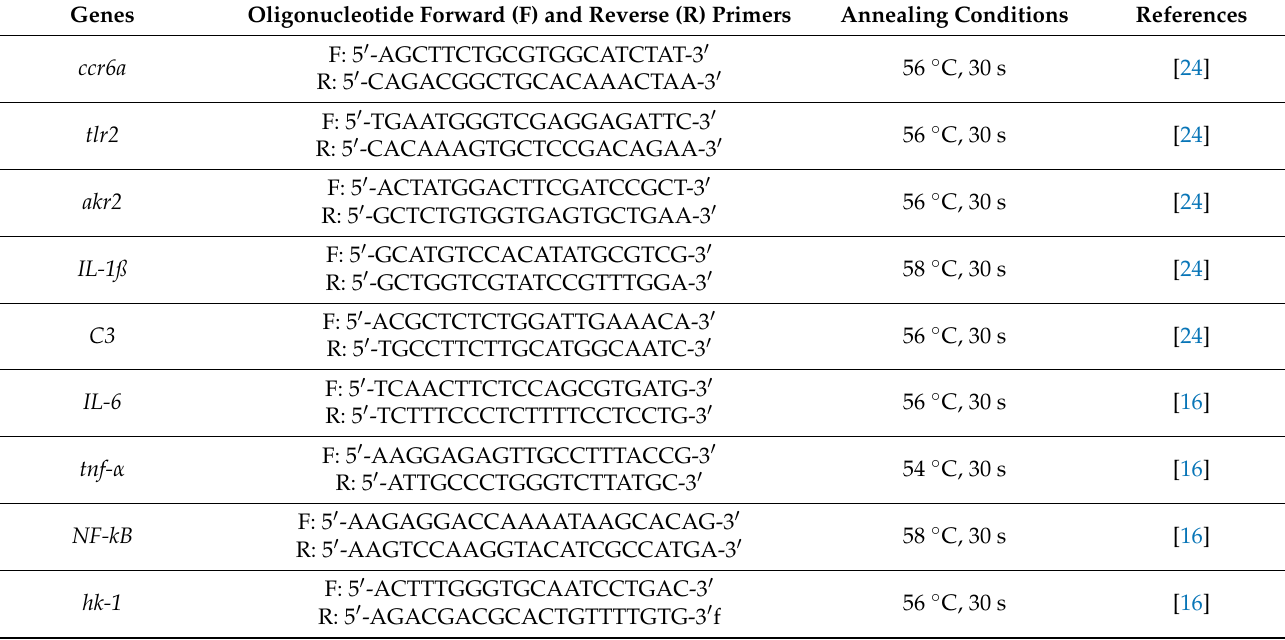
Table 4. Oligonucleotide primer sequences an annealing condition. Genes Oligonucleotide Forward (F) and Reverse (R)